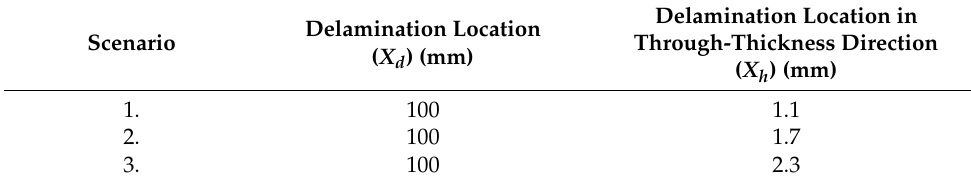
Table 2. Delamination position in the through-thickness direction.